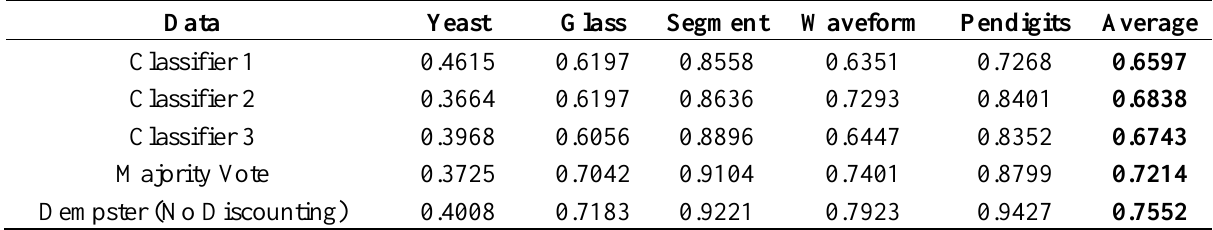
Table 8. Correct classification rates of classifiers and two